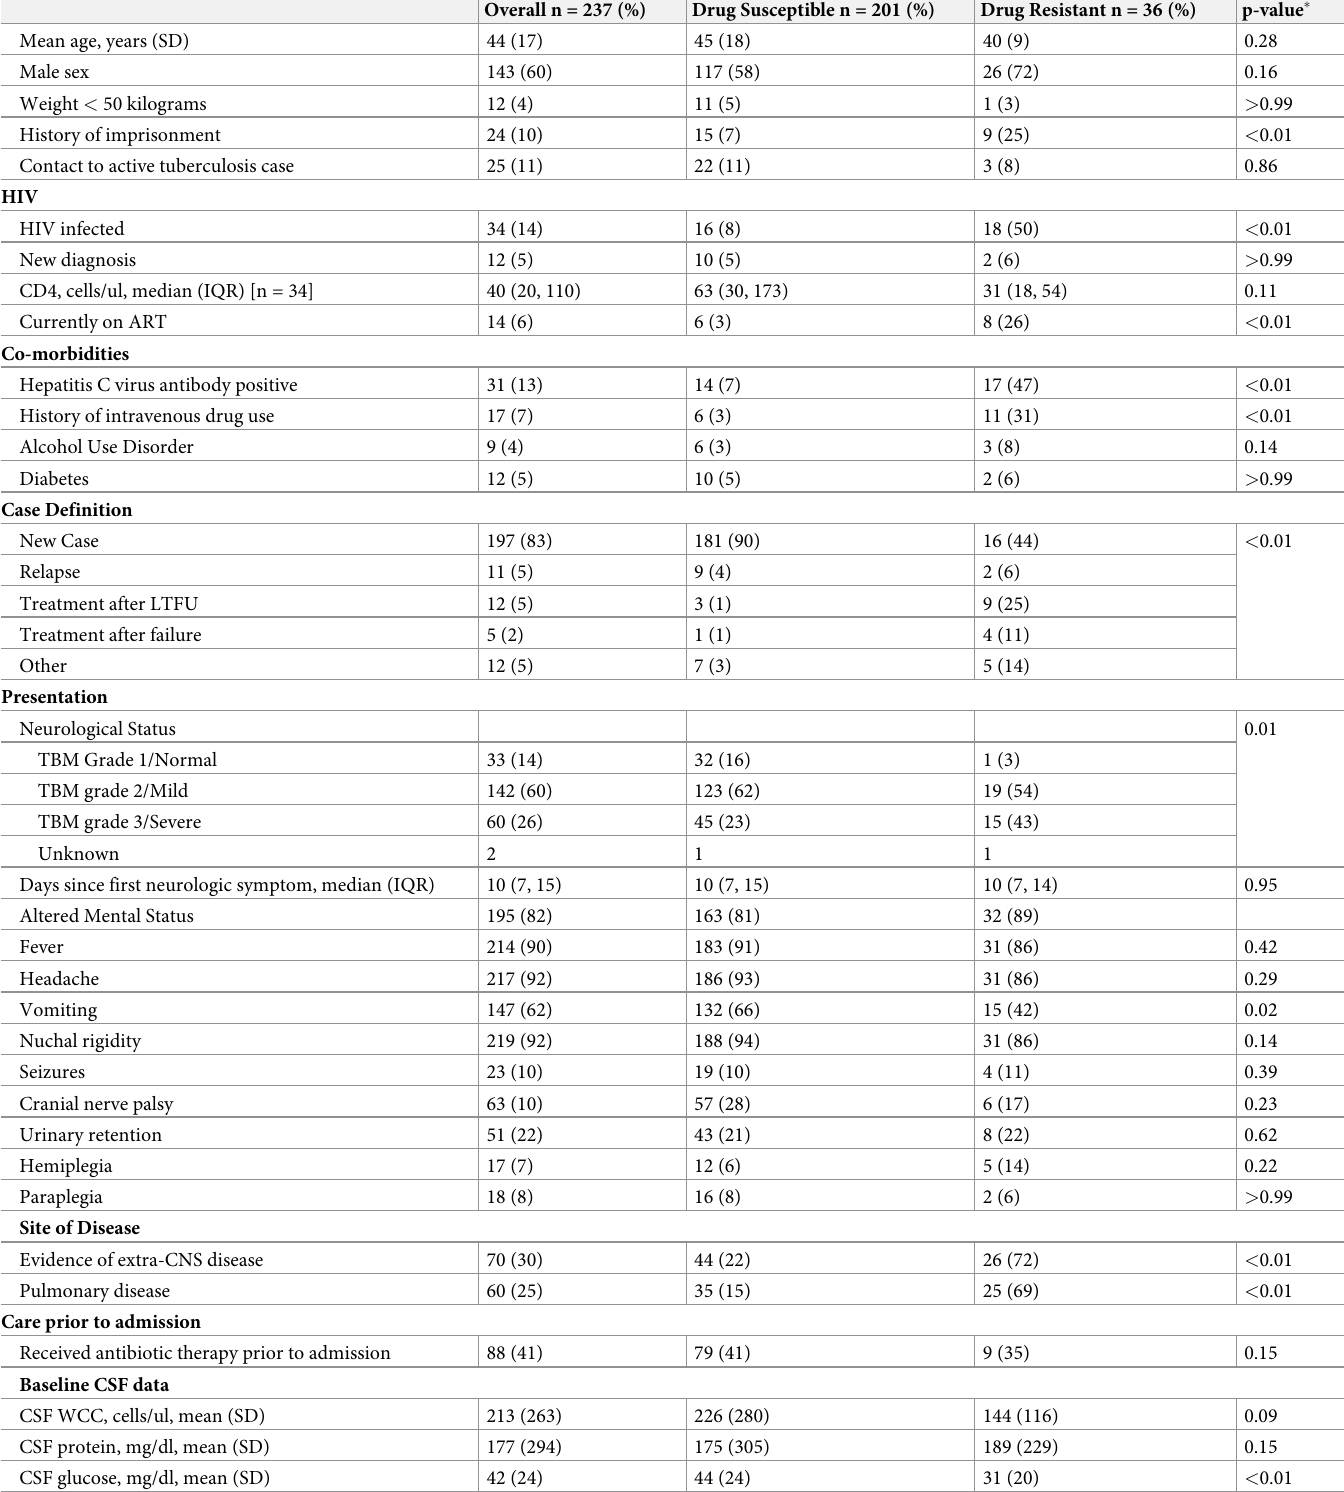
Table 1. Characteristics and outcomes of patients with tuberculosis meningitis by treatment type